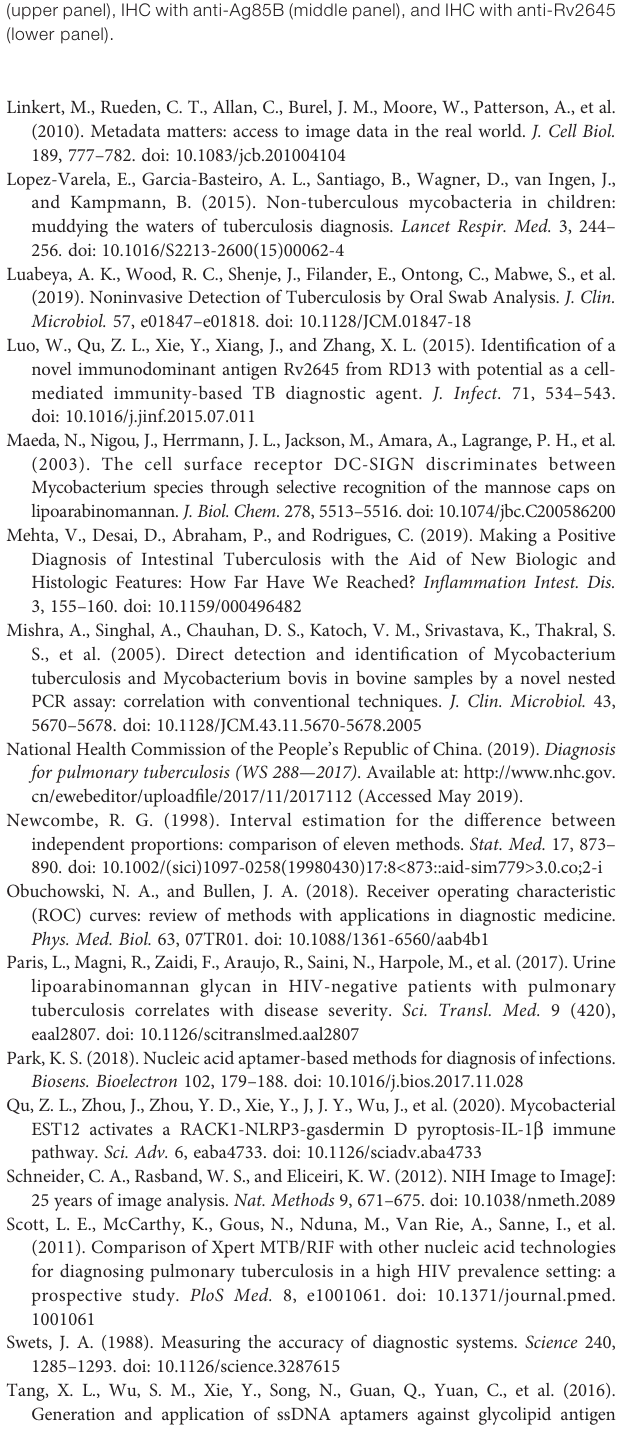
Supplementary Figure 1 | The fl ow diagram of the study. Details of patients are provided in the appendix. non-TB: other non-TB diseases (e.g.,